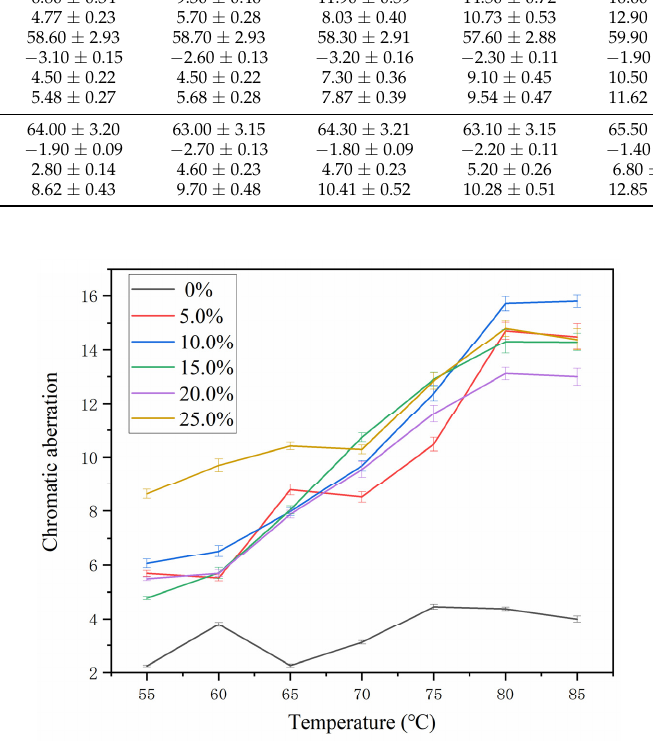
Figure 4. Effect of microcapsule content on the thermochromic difference of coating.